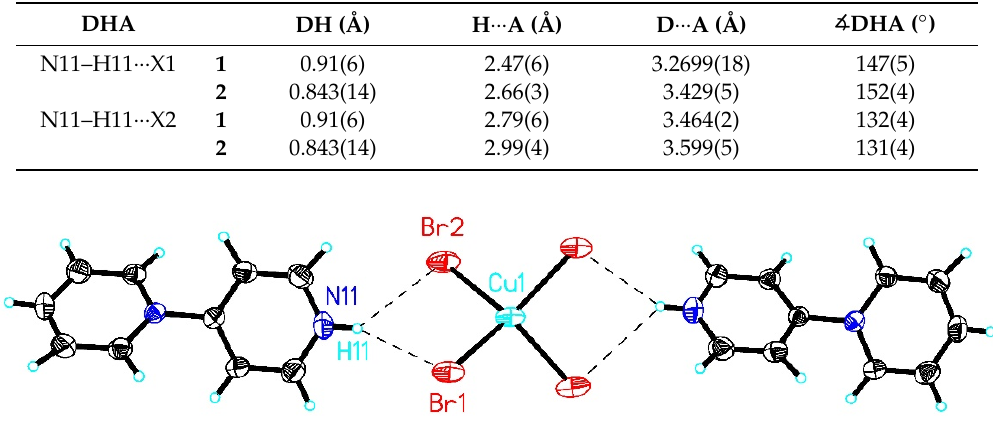
Figure 3. Br ··· H hydrogen bonding in 2 . See Table 3 for hydrogen bonding Figure 3. Br···H hydrogen bonding in 2 . See Table 3 for hydrogen bonding data. Table 3. Hydrogen bonding parameters in 1 and 2 .